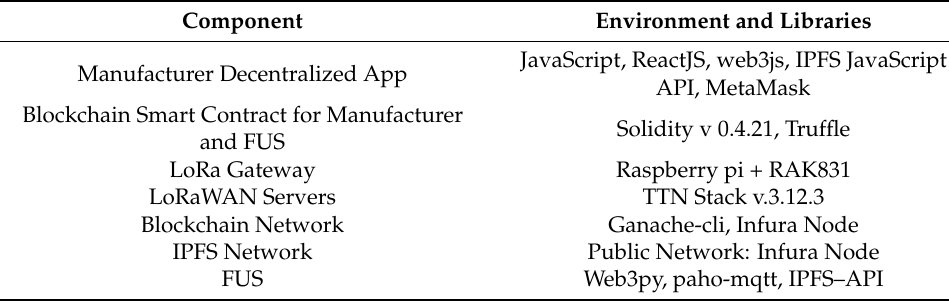
Table 6. Development Environment and Libraries.